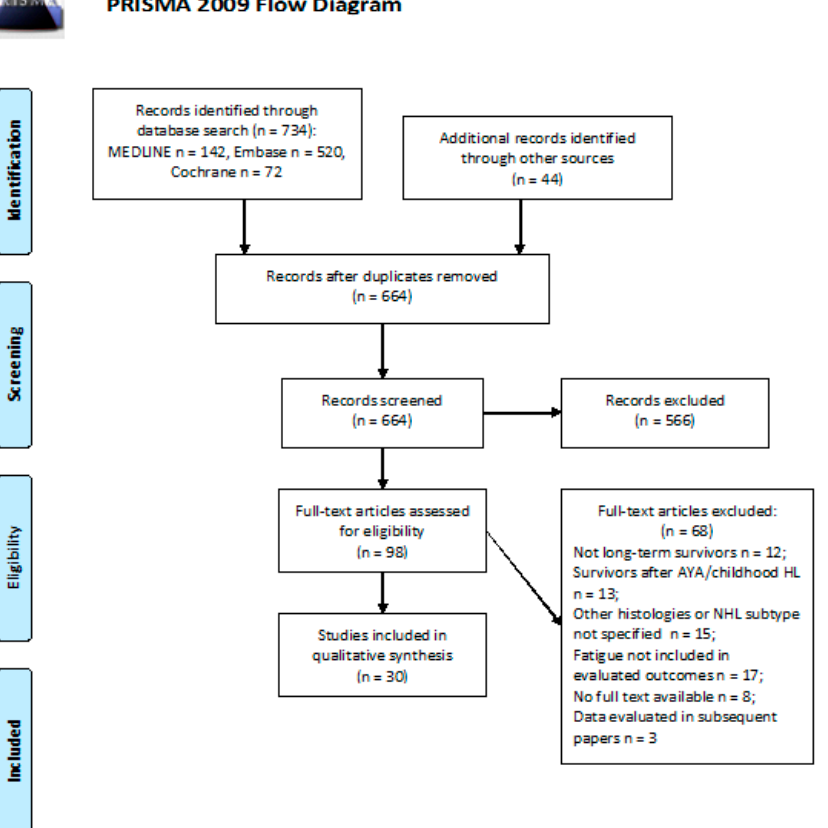
Figure 5. PRISMA flow diagram on the incidence of fatigue.